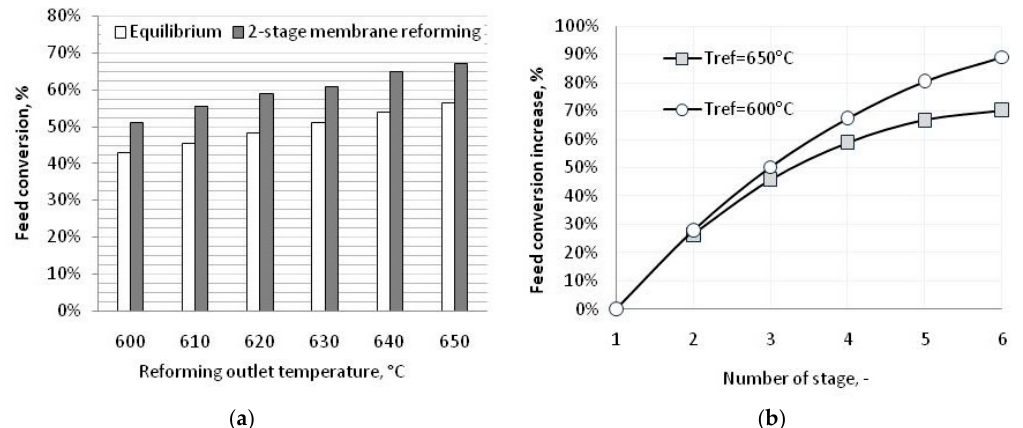
Figure 5. ( a ) Feed conversion for different reforming outlet temperatures (P = 10 barg, Steam/Carbon ratio S/C = 4.3 mol; Tmem = 410–420 °C, Amem = 0.4 m 2 , Molar sweep gas/feed ratio = 0); ( b ) Multistage membrane steam reforming performance (P = 10 barg, S/C 4.3, Tmem = 410–420 °C, Amem = 0.4 m 2 , Molar Sweep gas/feed ratio = 0).